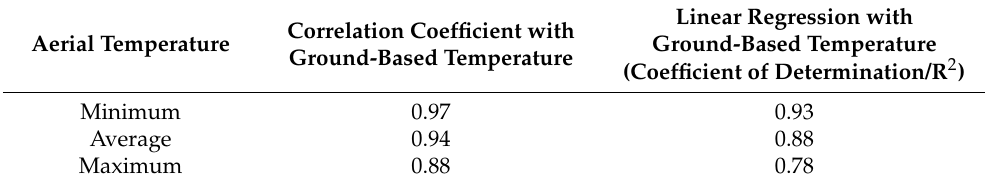
Table 3. Aerial temperature correlation coefficient and linear regression with ground-based tempera- ture.